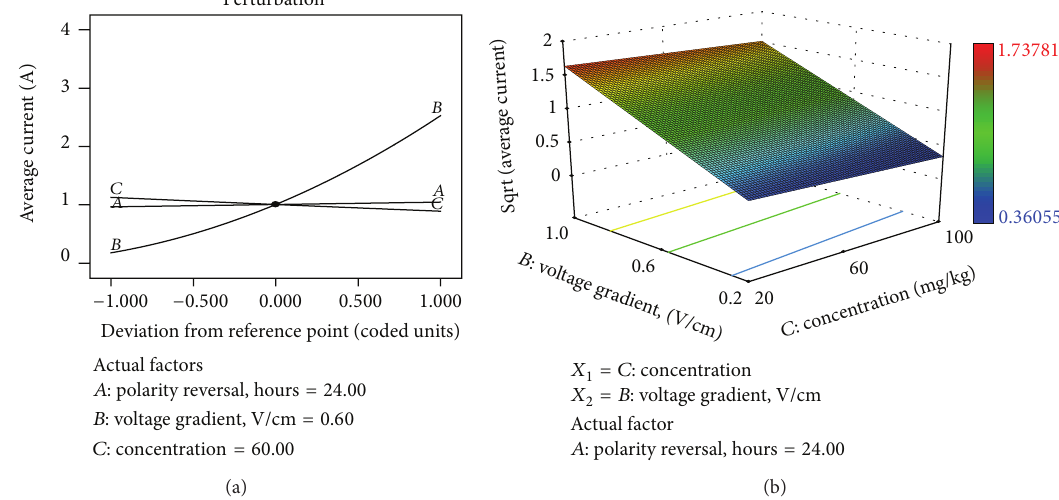
Figure 10: (a) Perturbation plot showing the relative significance of factors on average electric current. (b) 3D response surface and contour plots showing the influence of voltage gradient on average electric current.